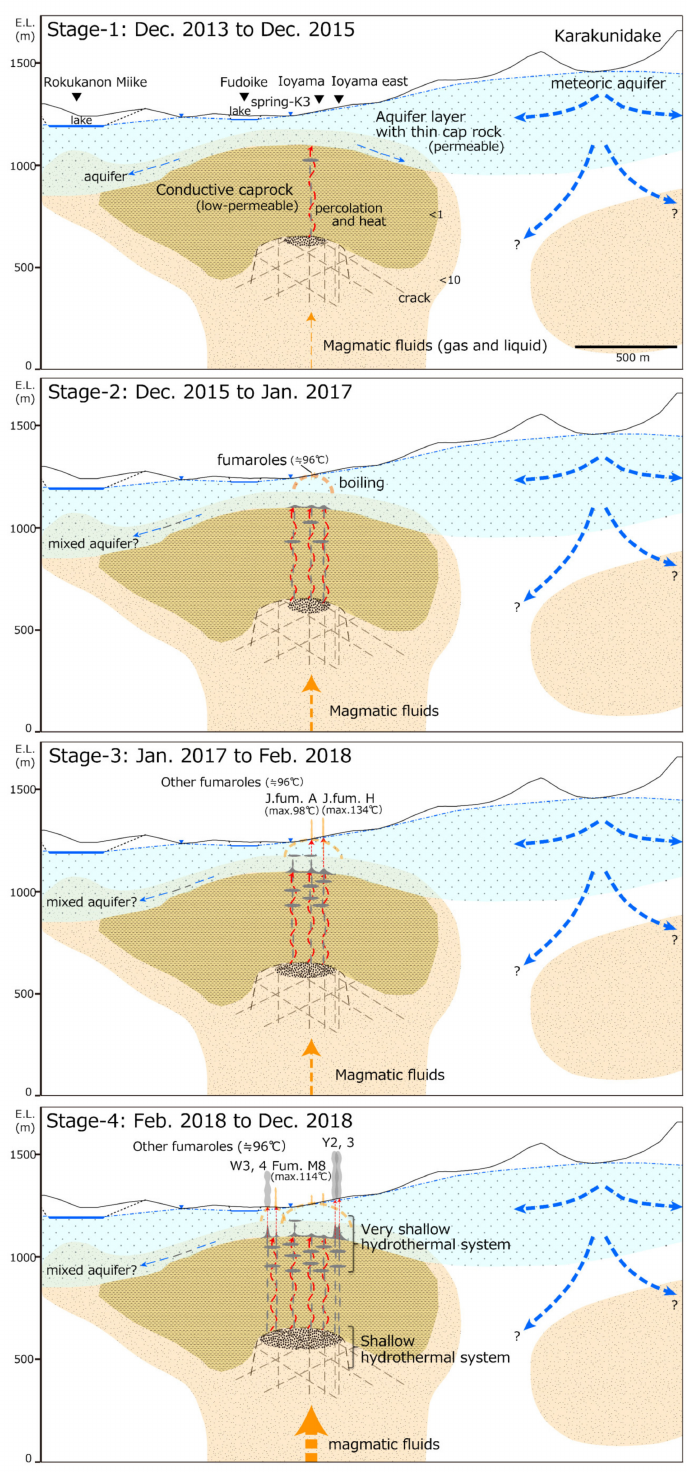
Figure 10. Conceptual sketch showing the di ff erent stages of geothermal activity in Ebinokogen Ioyama Volcano. Numerical values in Stage-1 denote Ω -m